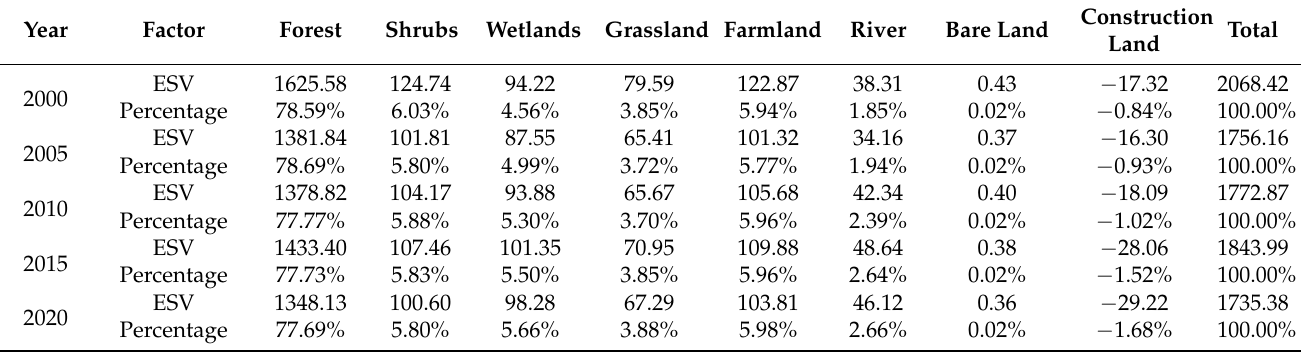
Table 7. ESV and proportion by ecosystem class in Hainan Province (unit: 10 6 CNY).